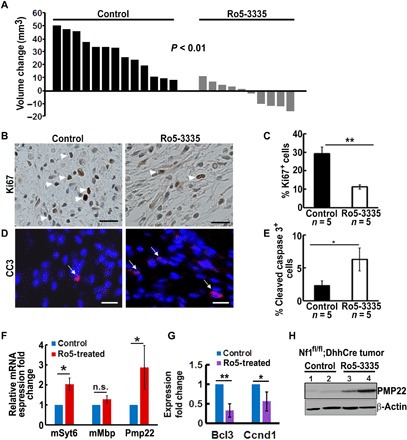
RUNX/CBFB interaction inhibitor, Ro5-3335, significantly decreases mouse neurofibroma growth in vivo.(A) Waterfall plot showed mouse tumor volume change. Data from each mouse were shown as a single bar. Change in tumor volume was quantified between 7 and 9 months for each individual mouse treated with vehicle control (control) (black bars; n = 13) or Ro5-3335 (gray bars; n = 10) for 8 weeks. (B and C) Ro5-3335–inhibited neurofibroma cell proliferation readout by the percentage of Ki67+ cells. (D and E) Ro5-3335–induced neurofibroma cell apoptosis as assessed by the percentage of CC3+ cells. (F and G) Relative mRNA expression of Ro5-3335–treated mouse neurofibromas compared with vehicle controls on up- (F) and down-regulated (G) genes. (H) Western blot of PMP22 in Nf1fl/fl;DhhCre tumors (1 and 2) and Ro5-3335–treated Nf1fl/fl;DhhCre tumors (3 and 4). β-Actin was used as loading control. *P < 0.05 and **P < 0.01.